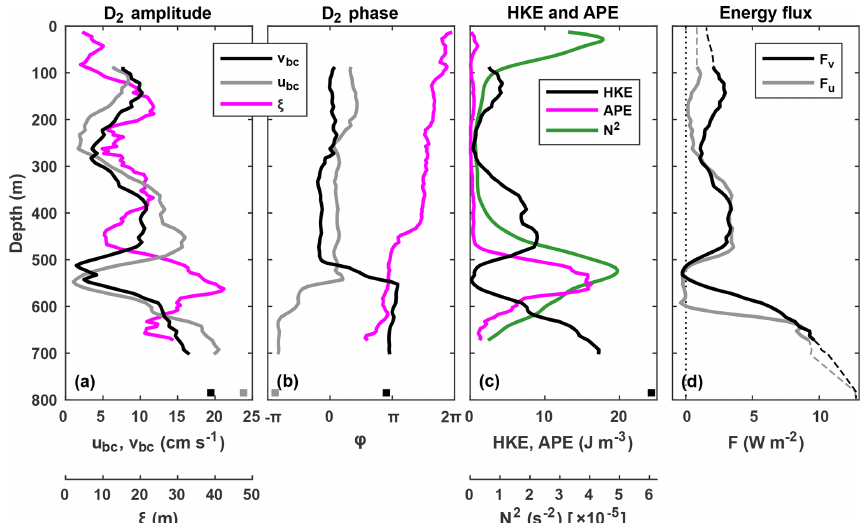
Figure 4. (a) Amplitude and (b) phase of the D 2 components of across-slope baroclinic velocity (black), along-slope baroclinic velocity (grey), and vertical isopycnal displacement (magenta). (c) Horizontal kinetic energy (black), available potential energy (magenta), and buoy- ancy frequency squared (green). (d) Across-slope (black) and along-slope (grey) D 2 internal tide energy flux. Solid lines indicate both glider and ADCP data coverage; dashed lines indicate that one or both of the datasets required extrapolation. Positive fluxes are down-slope and along-slope to the